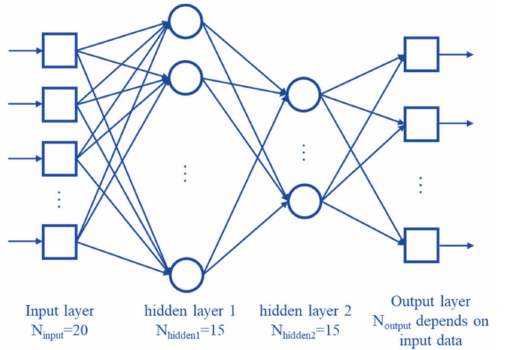
Figure 4. Double hidden-layer BP network structure